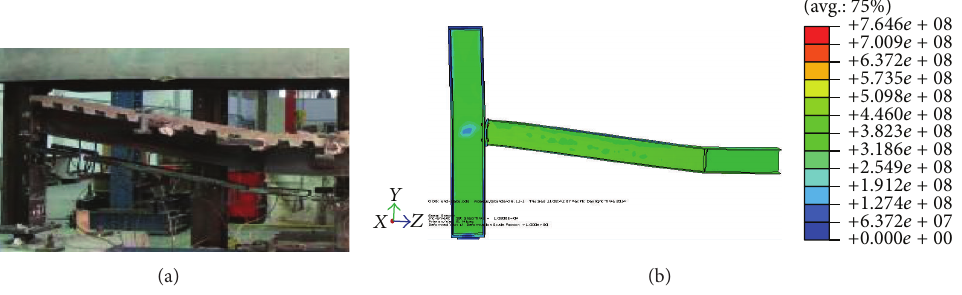
Figure 9: Deformation: (a) laboratory sample; (b) numerical mode.